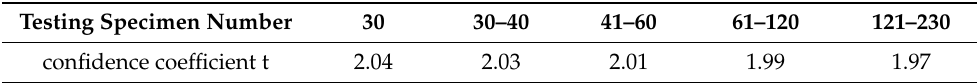
Table 2. Functional relationship between N and t (95% confidence